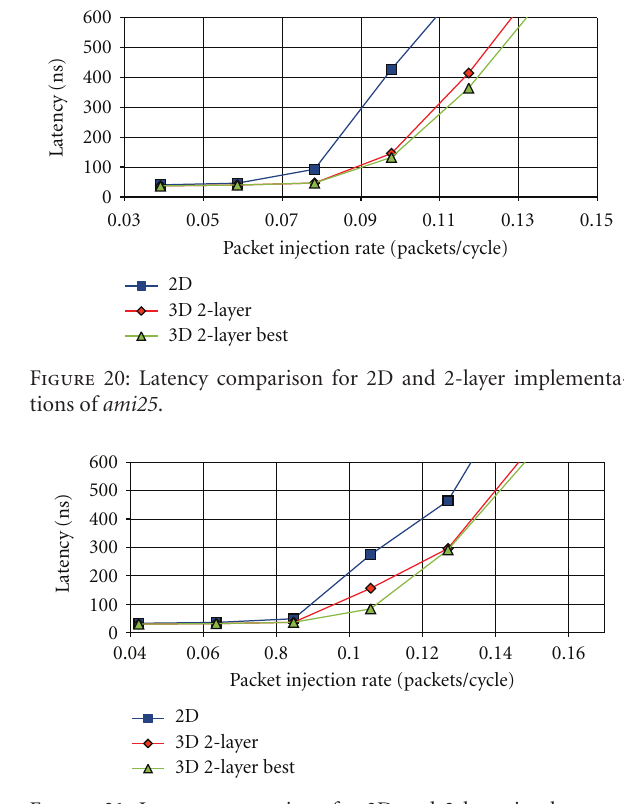
Figure 18: Latency comparison for 2D and 2-layer implementa- tions of xerox .